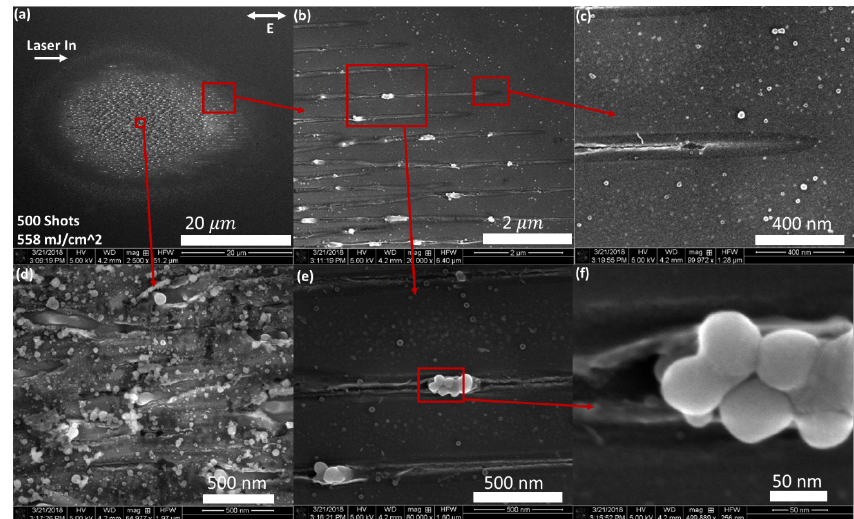
Figure 3. SEM images of multi-shot LID on silicon (111) with 500 shots. ( a ) shows an overall SEM image of the LID site. The fluence is indicated in the figure, as well as the direction of laser propagation and polarization, both projected onto the sample surface; ( b , d ) are zoom-ins of the red boxed areas in ( a ), as indicated by the red arrows; ( c ) is a zoom-in of a red boxed area in ( b ) as indicated by the red arrow; ( e ) is a zoom in of the larger red boxed area of ( b ), and an even larger magnification of ( e ) is shown in ( f ).